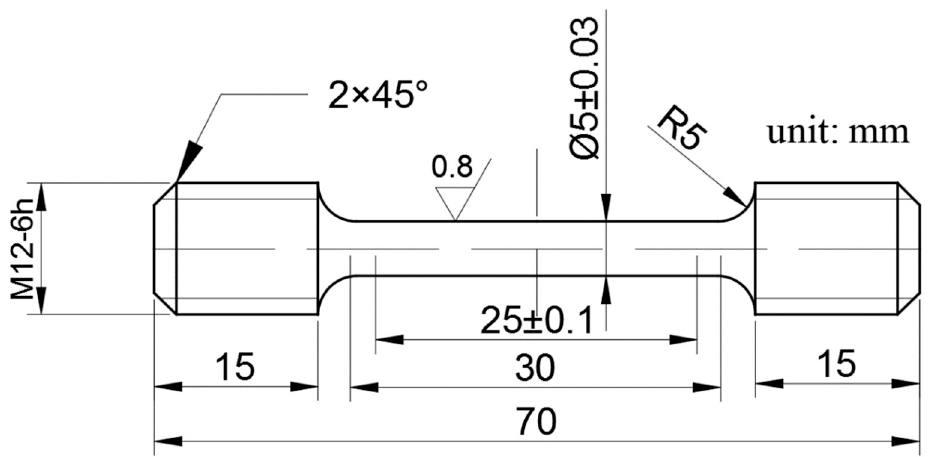
Figure 1. Dimensions of standard tensile specimens.